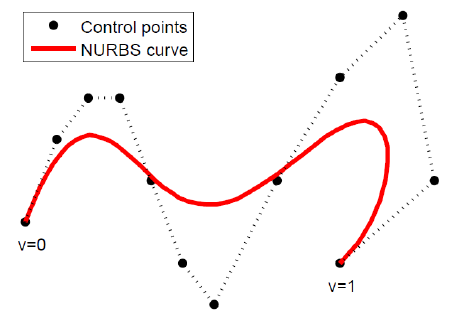
Figure 2: NURBS curve